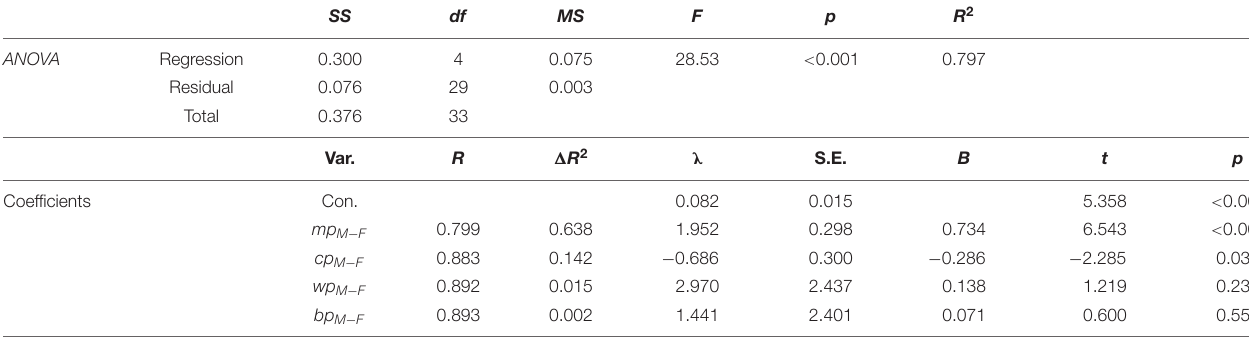
TABLE 1 | Regression model summary for Poly-BW indices on differential item functioning (DIF) measures. SS df MS F p R 2 ANOVA Regression 0.300 4